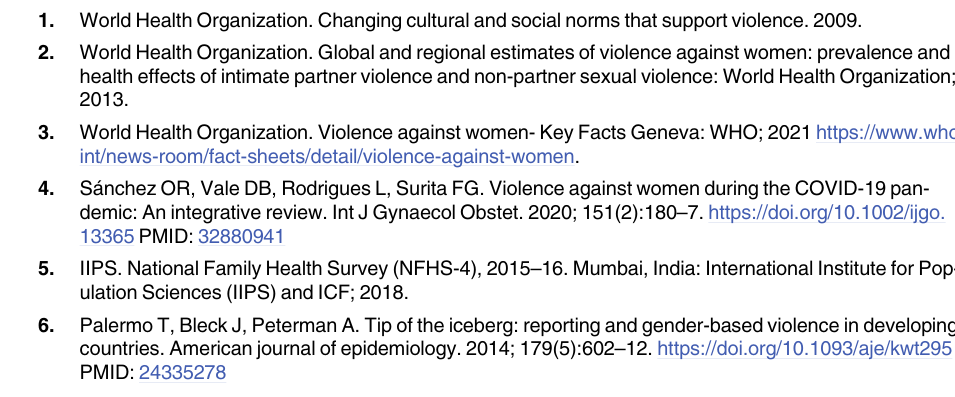
S1 Fig. Flowchart of the iterative thematic analysis process. S1 Table. Characteristics of all women included in the